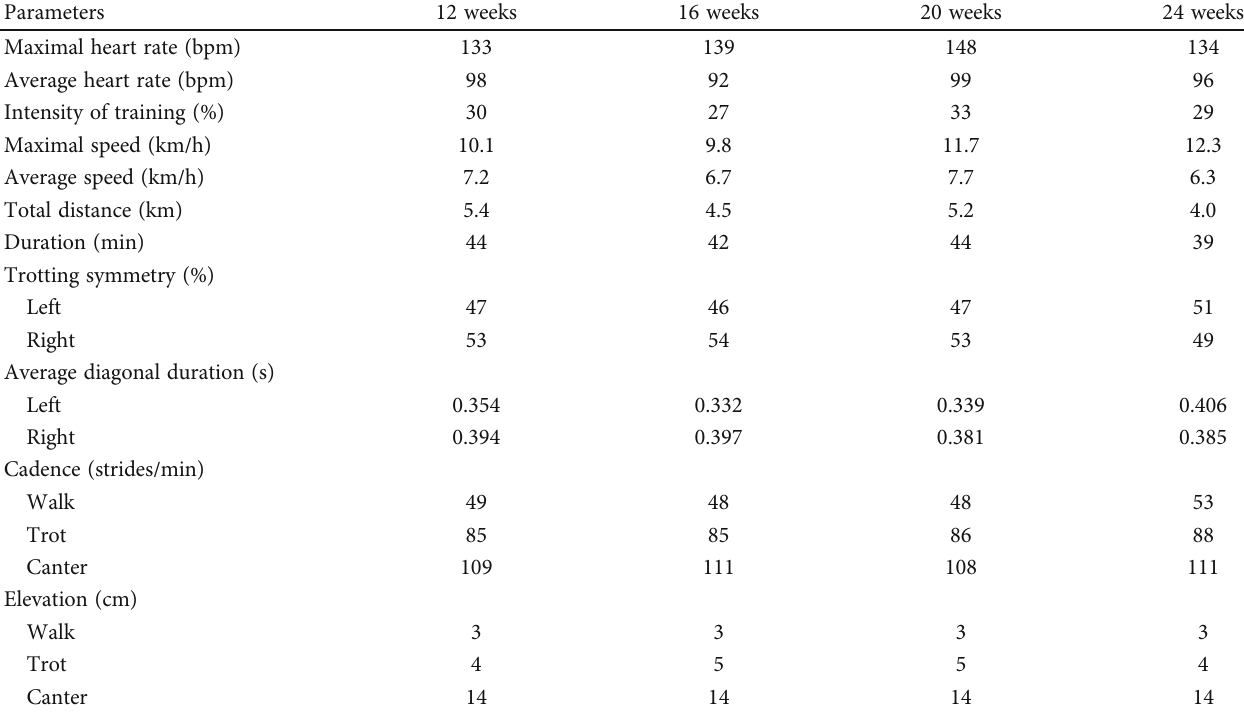
Table 1: The parameters obtained from the heart rate detection device during exercise training at 16, 20, and 24 weeks of z-bar shoeing. Parameters